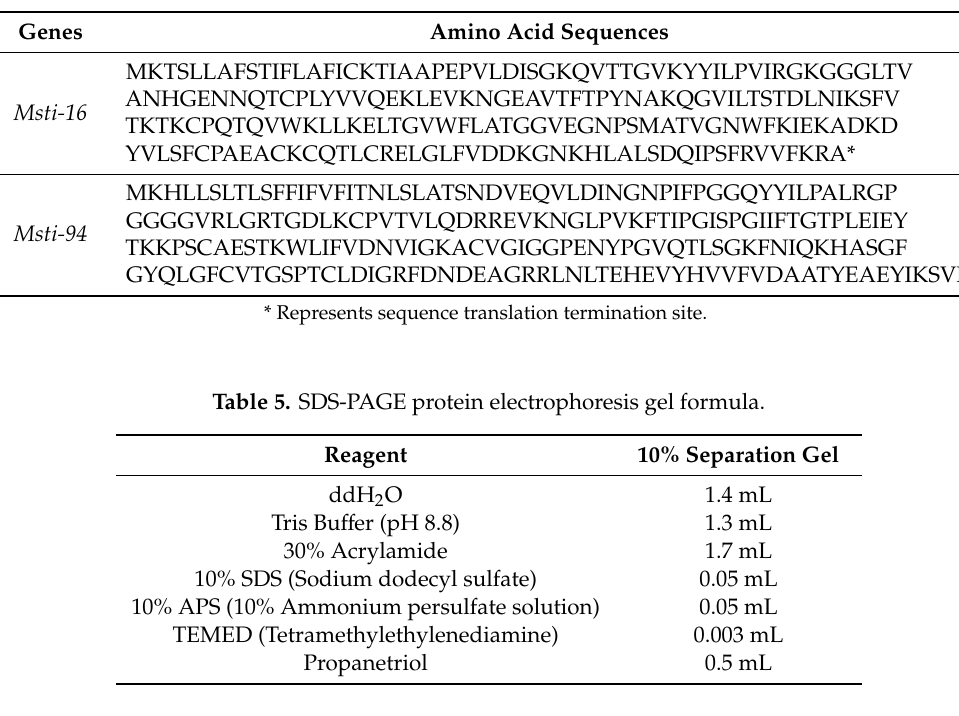
Table 4. Amino acid sequences of the selected Msti-16 and Msti-94 genes.